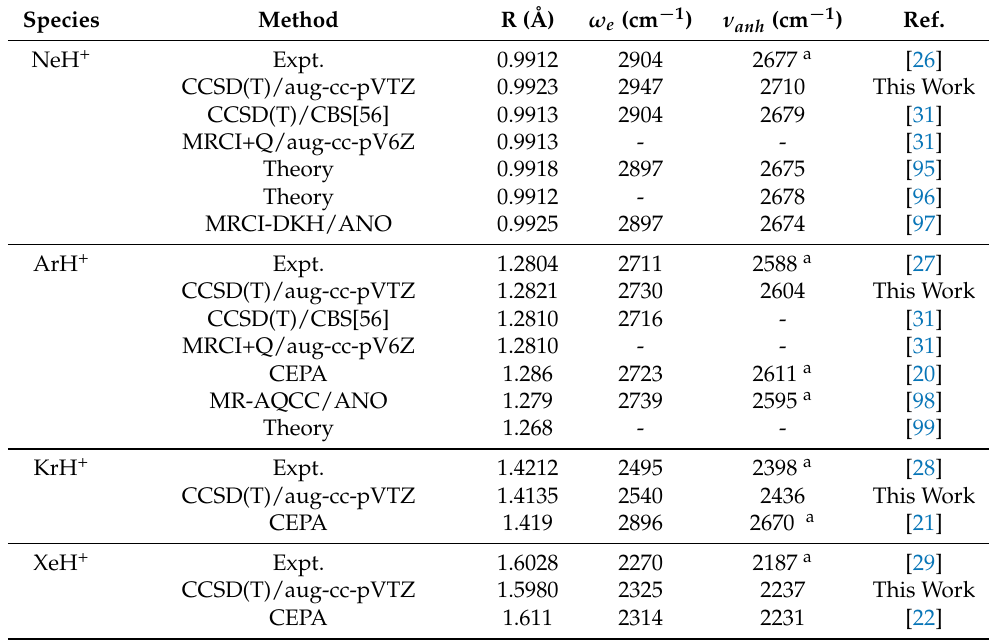
Table 1. Comparison of experimental and calculated structural parameter and vibrational frequencies. Species Method